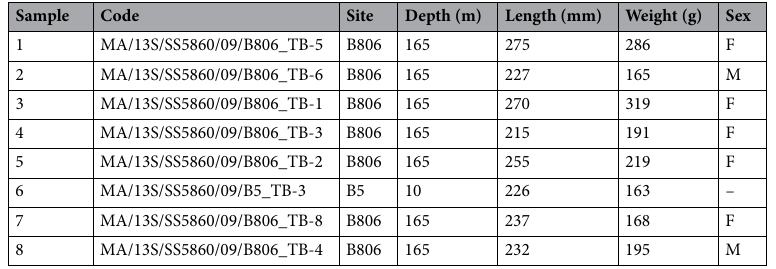
Table 3. Total length (mm) and total weight (g) ranges of the analysed Trematomus bernacchii